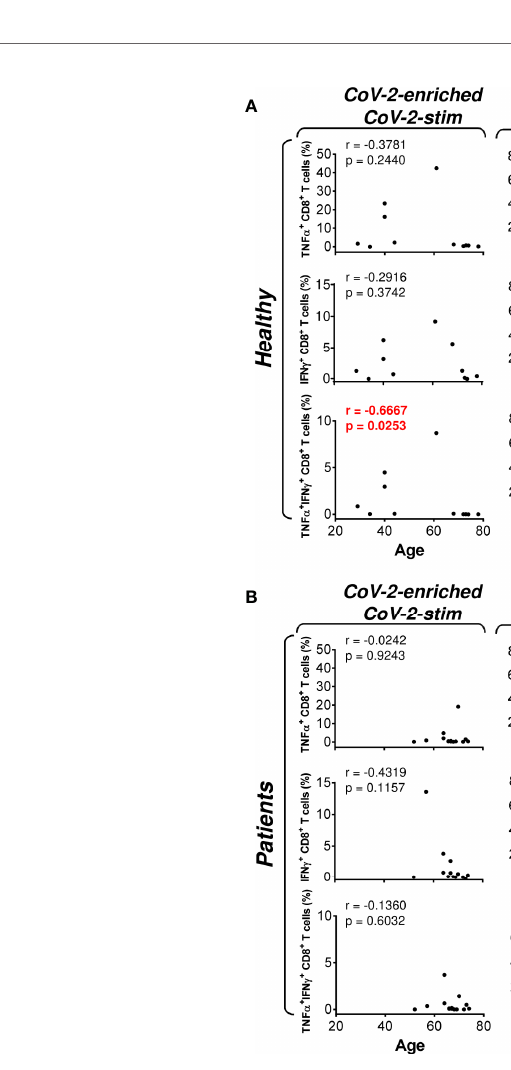
FIGURE 4 | Association of the healthy male volunteer ’ s and HR metastatic PCa patient ’ s age with the SARS-CoV-2/HCoV-229E peptide pool reactivity or SARS-CoV-2 peptide pool cross-reactivity of CD8 + T cells in the peptide-enriched cell cultures (A, B) Cell cultures of 11 healthy male volunteers (Healthy) (A) and 14 HR metastatic PCa patients (Patients) (B) were SARS-CoV-2-enriched/SARS-CoV-2-stimulated (CoV-2-enriched/CoV-2-stim), HCoV-229E-enriched/HCoV-229E-stimulated (229E-enriched/229E- stim), or HCoV-229E-enriched/SARS-CoV-2-stimulated (229E-enriched/CoV-2-stim) and the correlations of the subject ’ s age with the proportions of TNF a -, IFN g -, or TNF a / IFN g -producing CD8 + T cells determined. In (A, B) , the correlations were evaluated by Spearman ’ s rank-order correlation coef fi cient (r) and the signi fi cance ( P value) determined ( n = 11 healthy male volunteers, n = 14 HR metastatic PCa patients). In (A, B) , P > 0.05 were considered nonsigni fi